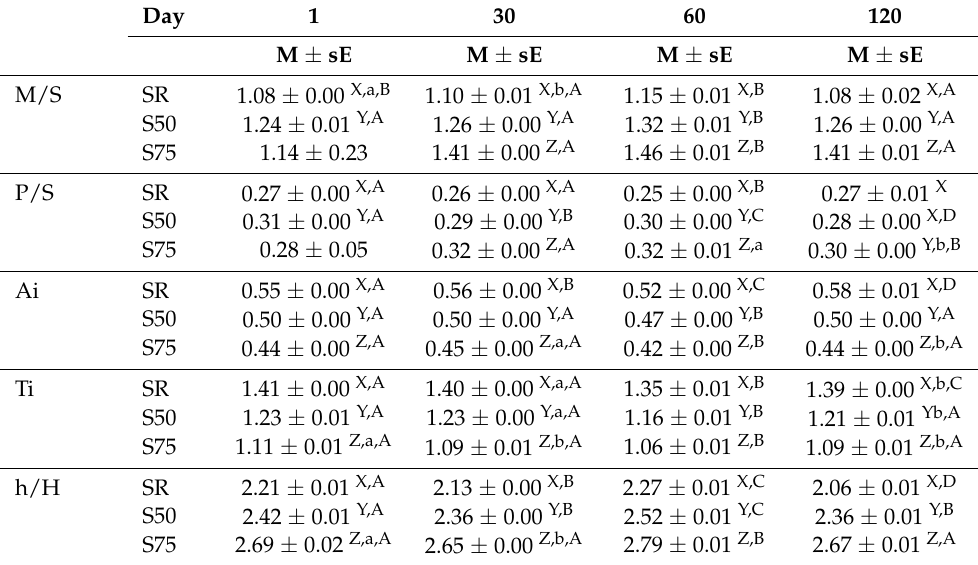
Table 3. Nutritional indices and the fatty acid ratio of three salami (SR, S50, and S75) during ripening.